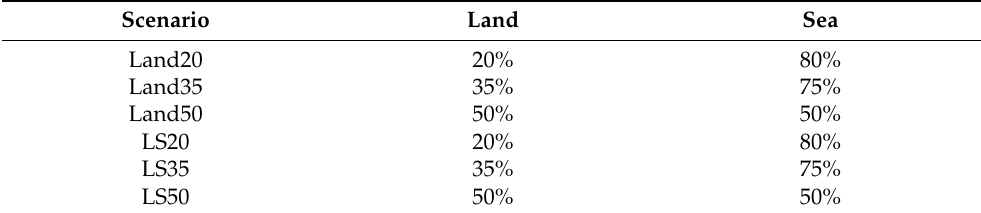
Table 2. Land/Sea Trade Ratios used for Price Shocks under Different Policy Scenarios.